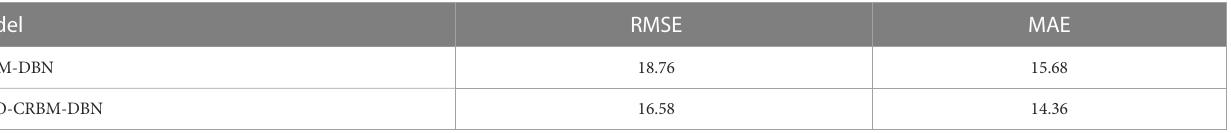
TABLE 2 Experimental